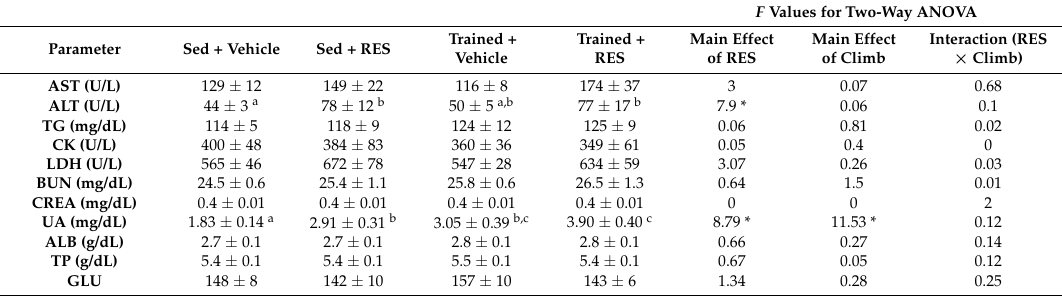
Table 2. Effects of climb training (Trained) and/or resveratrol (RES) on biochemical assessments of serum at the end of the experiment.